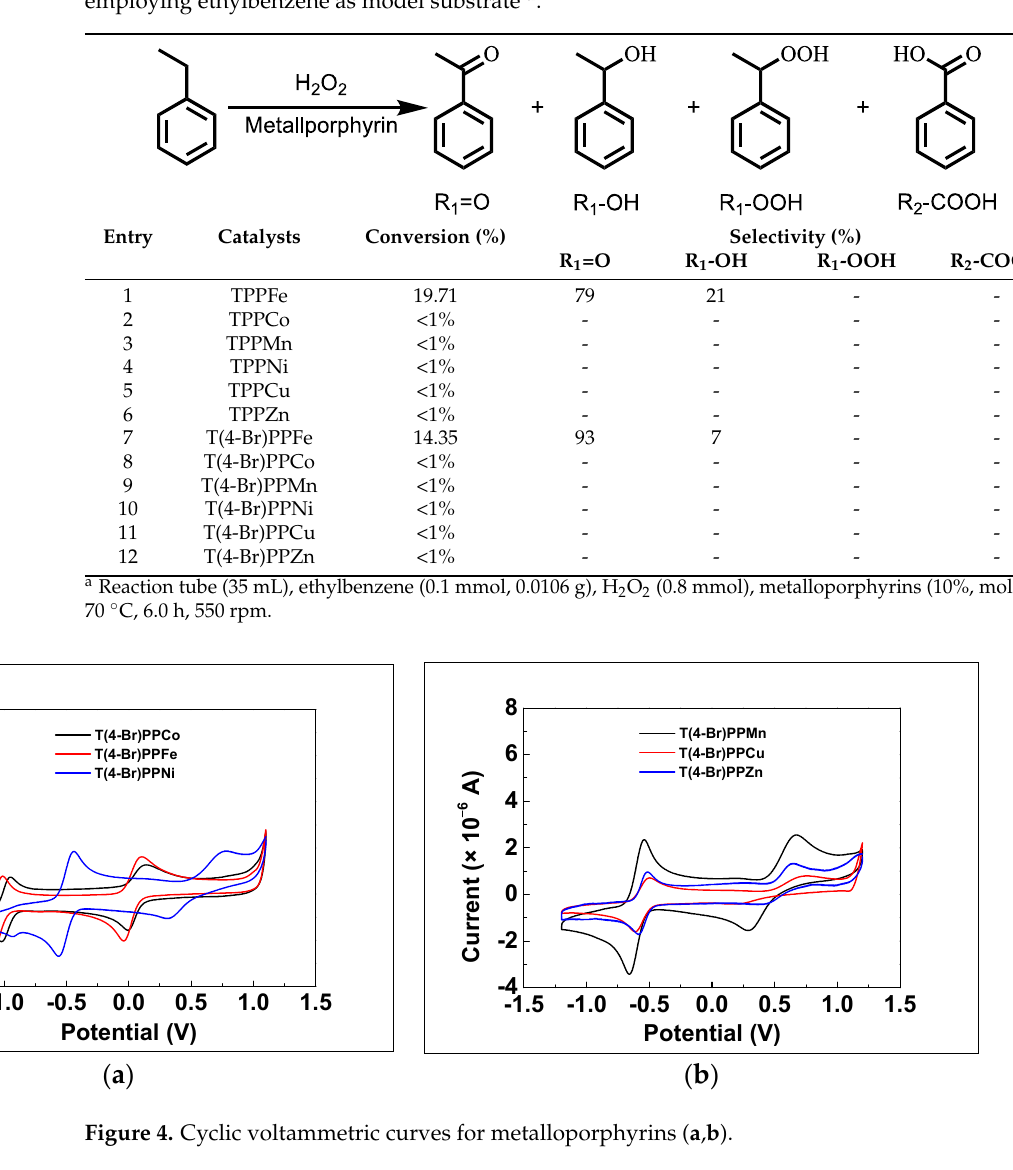
Table 2. Preliminary exploration on the e ff ect of metal centers on alkyl aromatics oxygenation em- ploying ethylbenzene as model substrate a .